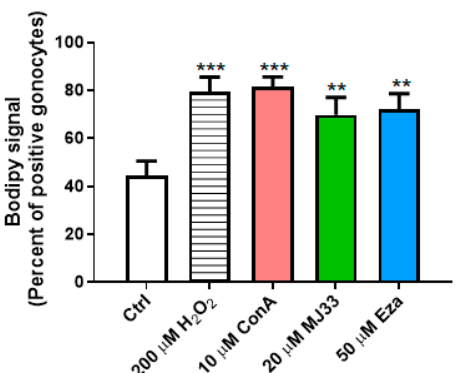
Figure 5. E ff ects of H 2 O 2 and PRDX inhibitors on lipid peroxide formation in PND3 gonocytes. H 2 O 2 and PRDX inhibitors were added for two hours on gonocytes. Lipid peroxidation was measured using the Bodipy assay. Results are the means ± SEM from at least three experiments. Statistical significance: ** p ≤ 0.01; *** p ≤ 0.001.